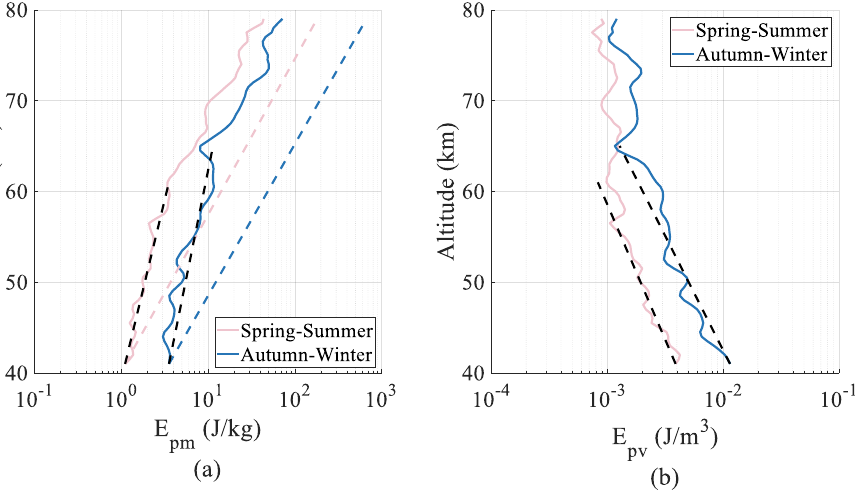
Figure 3. The seasonal profiles of GWPED above Jiuquan are shown as the red line in spring – summer and the blue line in autumn – winter. The colored dotted lines are the GWPED of the energy conservation AGWs, and the black dotted lines are the fitting of H pm ( a ) and H pv ( b ). Table 3. Scale heights ( H pm , H pv , and H) .